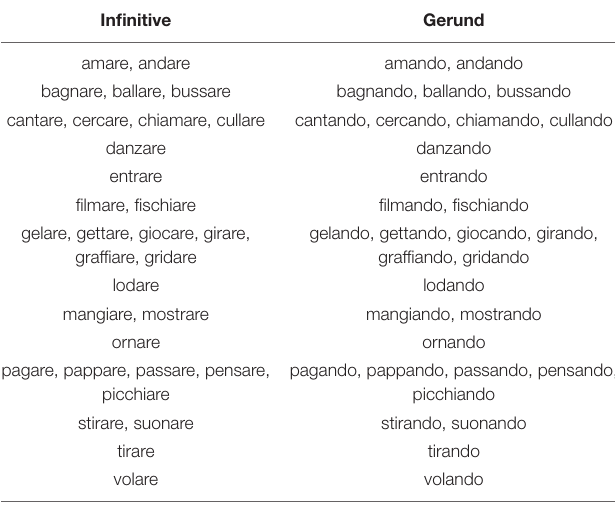
TABLE 4 | Overview of the 32 verb stems with the respective suffix combinations, used within